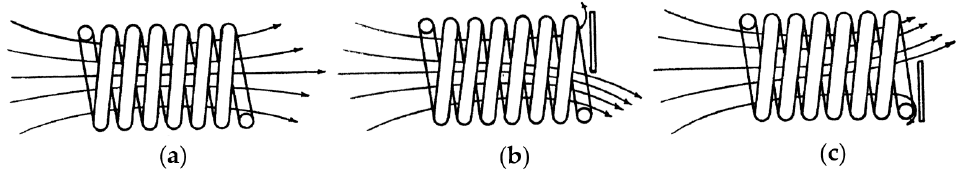
Figure 4. Flux steering method. (reproduced with permission from [11]. Copyright American Physical Society, 1946) ( a ) Unperturbed magnetic flux generated by a solenoid; a metallized paddle being used to steer flux ( b ) downwards or ( c ) upwards in the same coil. The receive coil is not shown.